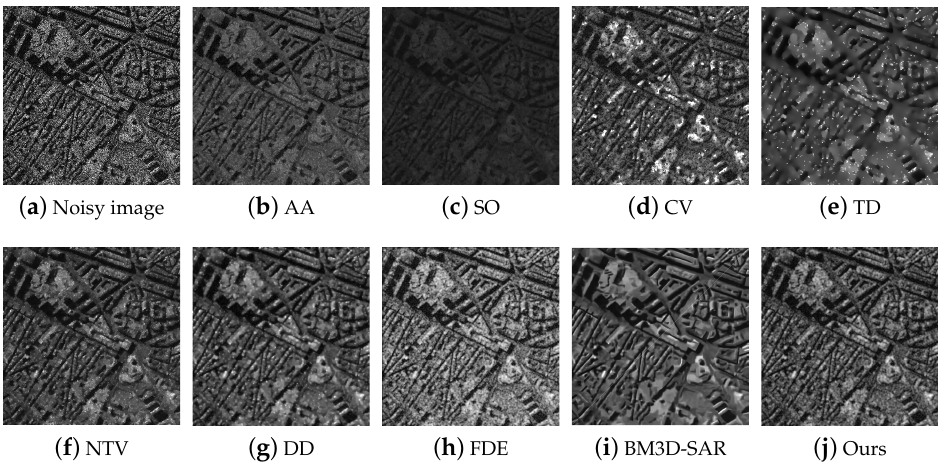
Figure 5. The despeckled results on the satellite1 image: ( a ) Noisy: L = 1. ( b – j ) Despeckled